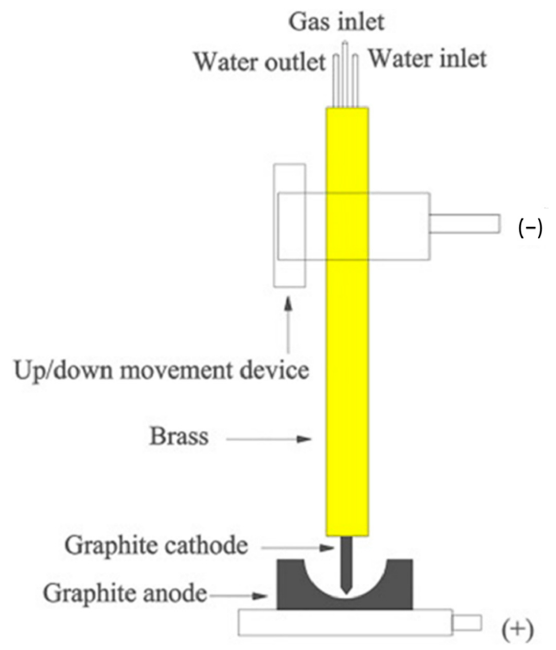
Figure 10. Low-pressure arc plasma. Reprinted from [43] with permission from Elsevier 1996.